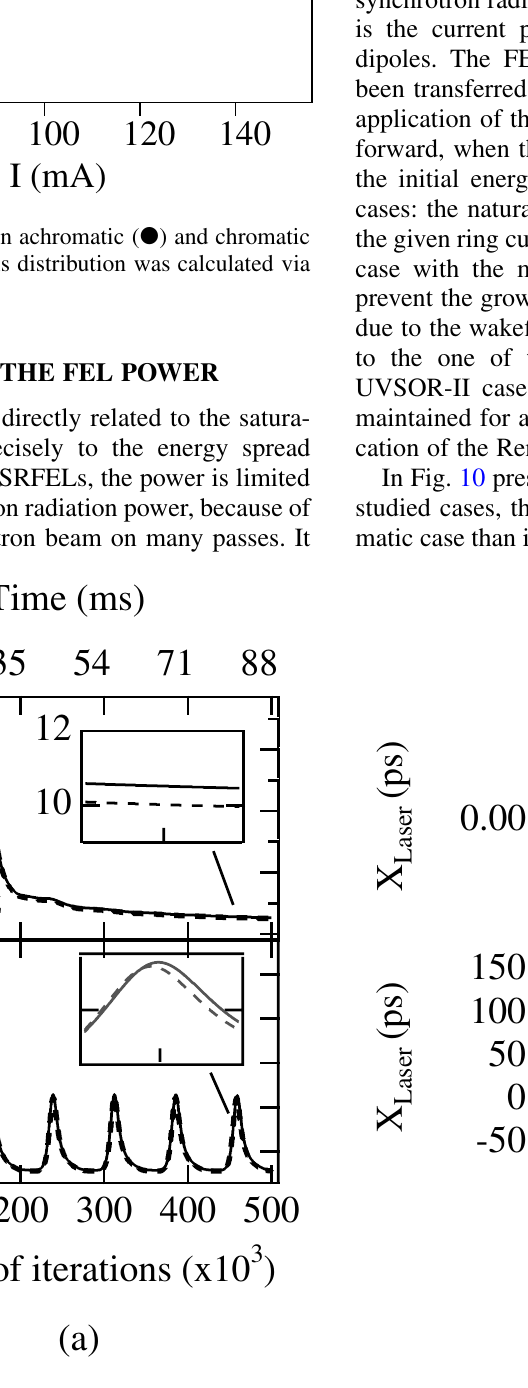
FIG. 13. FEL features calculated with LAS in achromatic (continuous line) and chromatic (dotted line) cases for two detuning values: (cid:12) (cid:6) 0 and (cid:12) (cid:6) 5 Hz (pulsed zone). Simulation performed for I (cid:6) 10 mA , and P (cid:6) 0 : 12% . (a) FEL pulse duration, (b) FEL center of mass